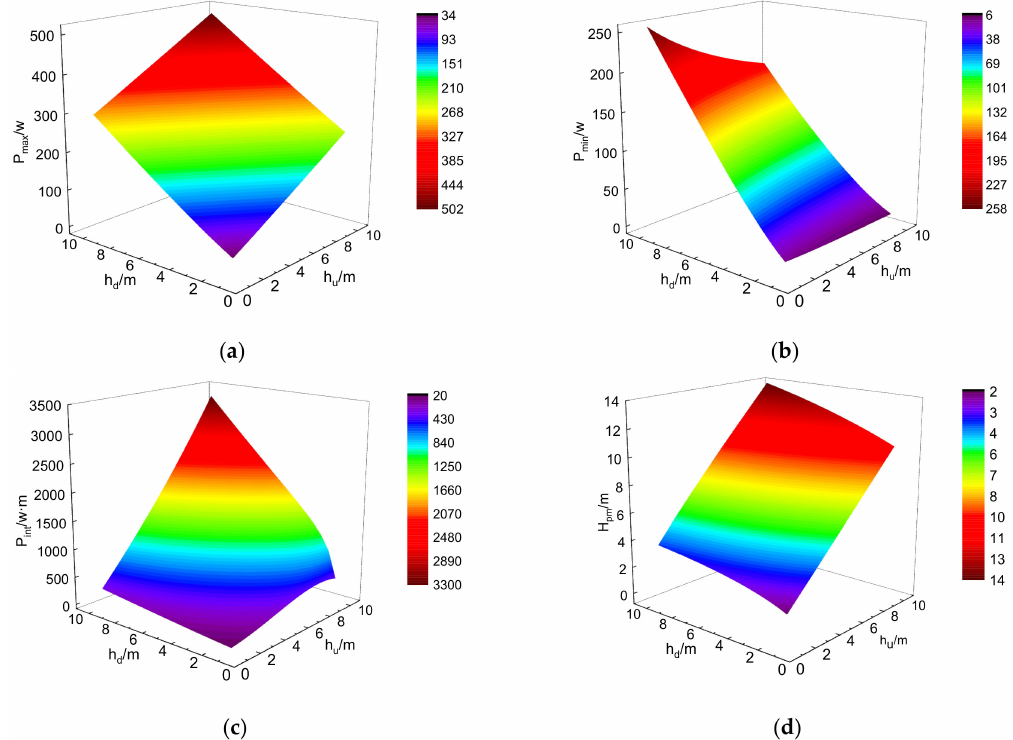
Figure 8. Relationships among P max , P min , P int , and H pm vs. h d and h u : ( a ) The maximum instantaneous power, P max ; ( b ) the minimum instantaneous power, P min ; ( c ) the integral of instantaneous power, P int ; ( d ) the maximum vacuum, H pm